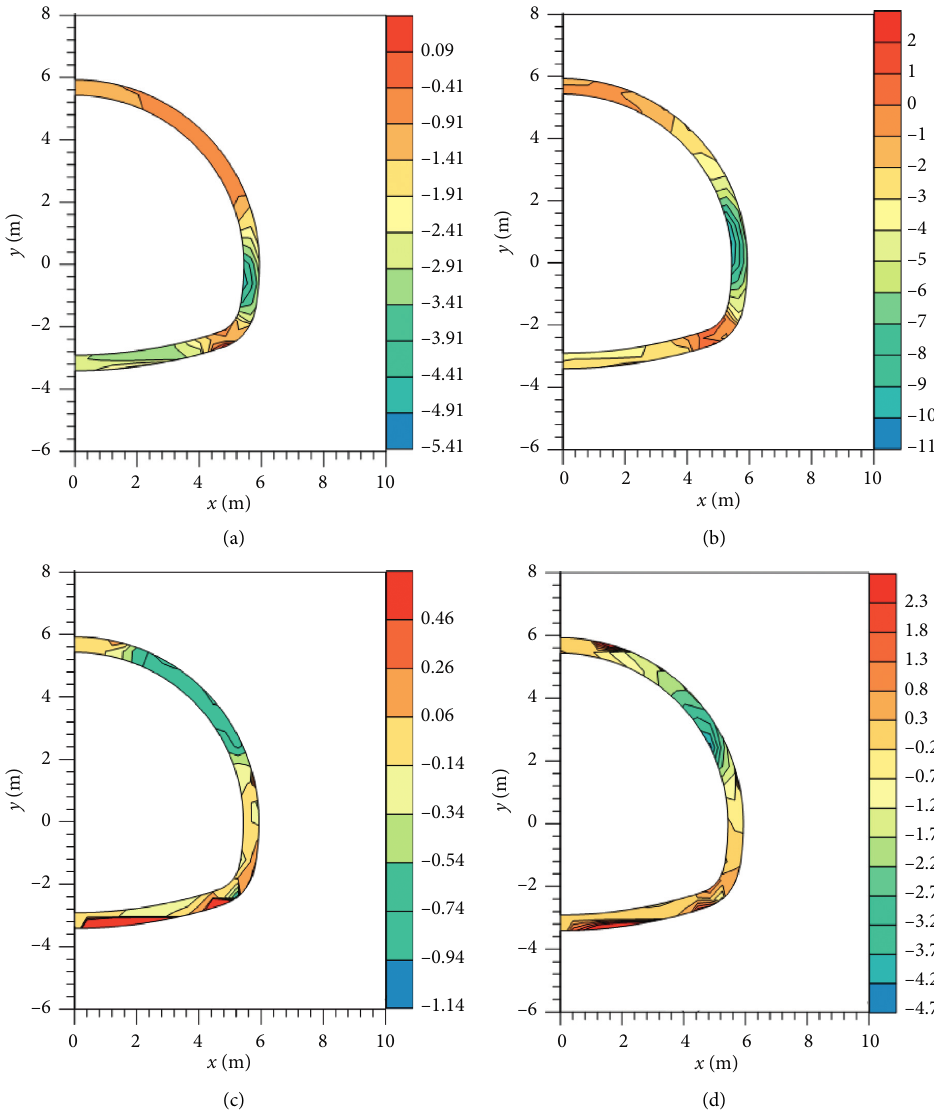
Figure 10: Stress regimes of the second lining structure at D1 on April 15 in 5 years of the operation period of the tunnel. (a) MAPS in STIL. (b) MAPS in WTIL. (c) MIPS in STIL. (d) MIPS in